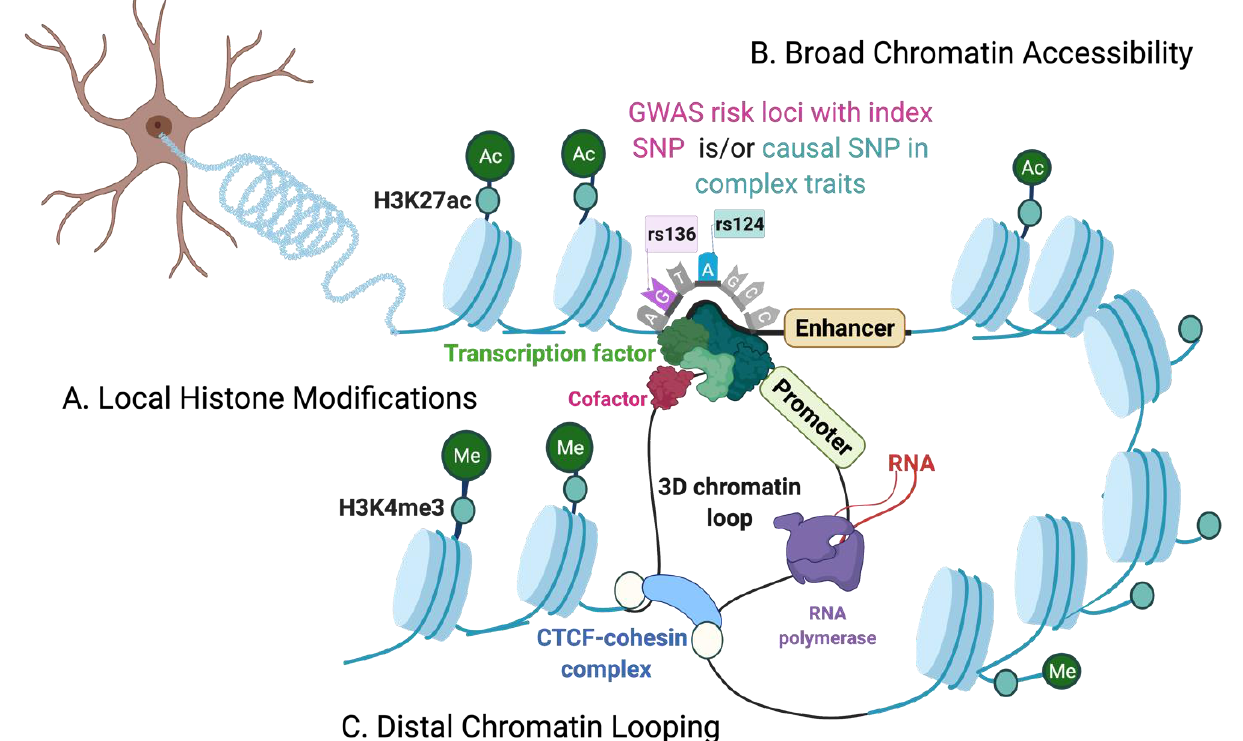
Figure 1. The Chromatin Environment. The open chromatin includes both coding and non-coding aspects of the genome. The interactions between cis- and trans- non-coding, regulatory elements and genes can occur at different genomic scales: locally (such as by histone modifications) or distally (such as by 3-dimesional interactions). The dynamics and functions of the chromatin environment can be mapped using chromatin profiling techniques. ( A ) Local histone modifications (such as acetylation or methylation): induce changes in the chromatin permissiveness, allowing binding of regulatory proteins like transcription factors, impacting expression of the nearby genes. The binding of transcription factors and histone modifications can be assayed using ChIP-seq, CUT&RUN, or CUT&TAG. ( B ) Broad chromatin accessibility: involve significant remodeling of the chromatin landscapes and redistribution of multi-nucleosomes that can directly or indirectly impact expression of multiple genes in the neighborhood. The chromatin environment, cis-regulatory elements and nucleosome distribution can be assayed using ATAC-seq, MNase-seq, DNase-seq, or FAIRE-seq. Genome-wide association studies (GWAS) risk loci for complex traits also largely map to the open non-coding genome, where the index or lead single-nucleotide polymorphism (statistically most significant SNP at a risk loci) may or may not be the disease causative SNP. Identifying regulatory roles of the epigenomic elements associating with risk variants can ascertain causal epi/genetic mechanisms of the complex traits. ( C ) Distal chromatin looping: facilitates long-range gene regulation by DNA elements located farther apart from gene promoters (more than 1–2 kbps), involving 3D changes in the chromatin topology. The spatially interacting genomic regions can be mapped using 3C, 4C, 5C, or HI-C. Additionally, genome-wide chromatin looping interactions of a regulatory protein can be assayed by ChIA-PET, 3C-ChIP, HiChIP, or PLAC-seq.